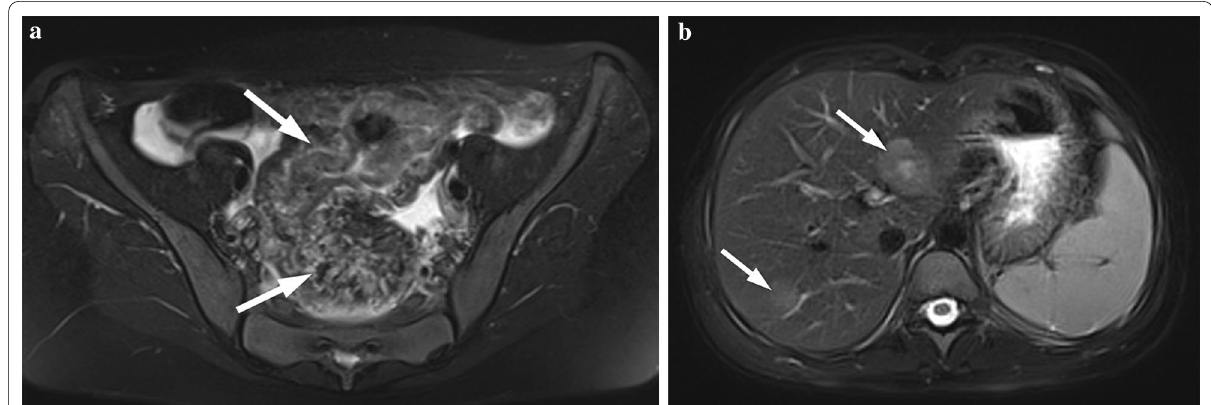
Fig. 4 a, b A 14-year-old girl with colon adenocarcinoma. She had blood in her stool and tenesmus for the last 1 month. Hb level was 6.3 gr/dL (normal range 11.7–15.5 gr/dL), Ca 19–9: 539 U/mL (normal range 0–35 U/mL), CeA: 207 ng/mL (normal range 0–7 ng/mL). US showed multiple lesions in the liver with hypoechoic halo. a Axial fat-saturated T2-weighted MRI demonstrates increased wall thickening at the sigmoid and